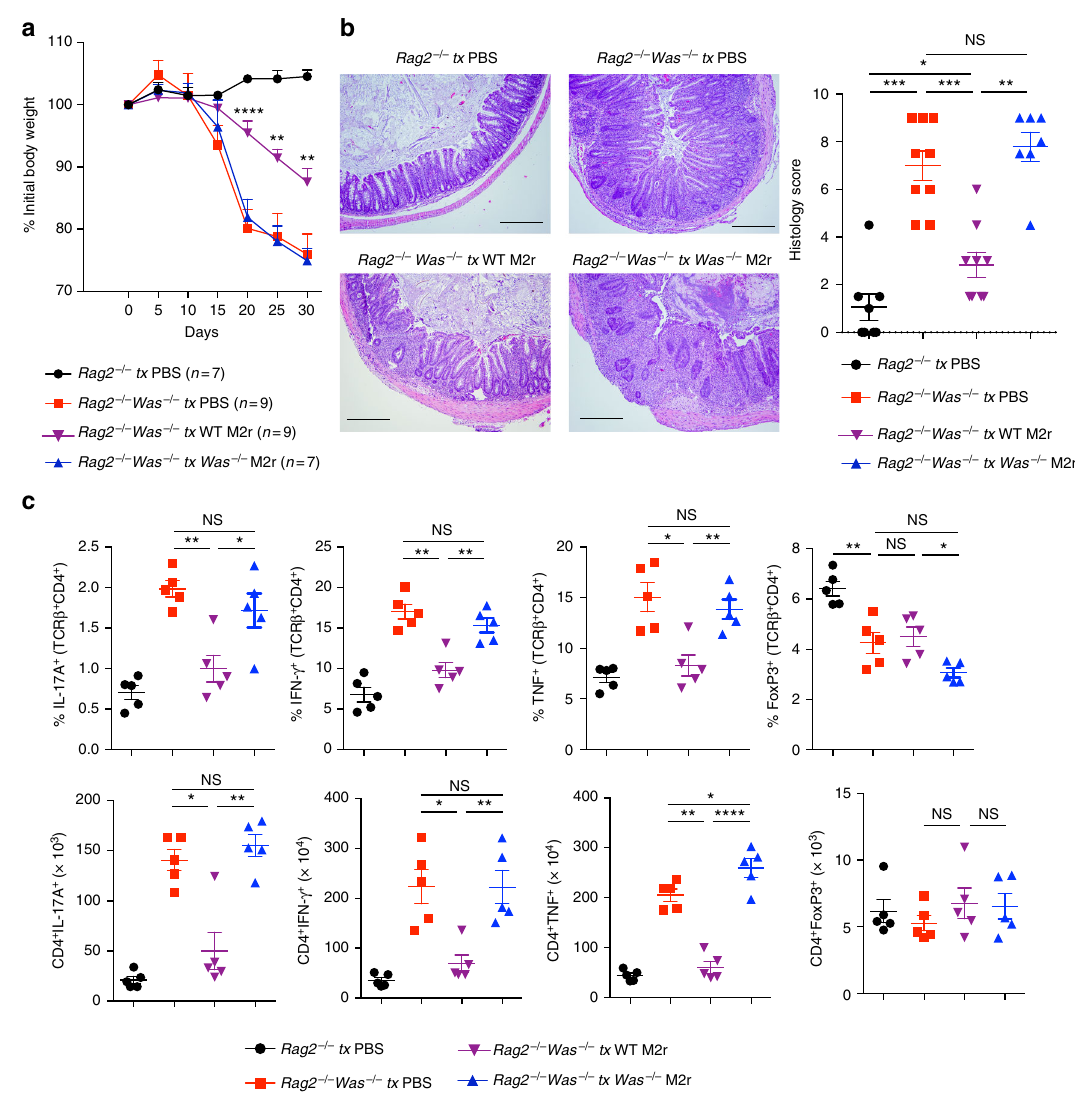
Fig. 5 Wild-type M2r macrophage protect Was − / − Rag − / − mice from T-cell-transfer-induced colitis. Was − / − Rag1 − / − mice were transfer with PBS ( n = 9), WT M2r (2 × 10 6 ) ( n = 9) or Was − / − M2r (2 × 10 6 ) ( n = 7) macrophages one-day before WT CD4 + T-cell transfer. As a control Rag1 − / − ( n = 7) were treated with PBS and transferred with WT CD4 + T cells. a Mean ± SEM % initial body weight after T-cell transfer. Data are cumulative of two independent experiments. * *p < 0.01, * **p < 0.001 (two-way ANOVA) ( Was − / − Rag1 − / − tx PBS Vs Was − / − Rag1 − / − tx WT M2r). b Representative photomicrographs of H&E stained colonic section and histological score. Scale bars: 200 μ m. c Absolute number and frequency of cytokine producing helper T cells in the LP was determined by fl ow cytometry. ( Rag1 − / − tx PBS n = 5; Was − / − Rag1 − / − tx PBS n = 5; Was − / − Rag1 − / − tx WT M2r n = 5; Was − / − Rag1 − / − tx Was − / − M2r n = 5). Data are cumulative of two independent experiments. Data shown in b , c are mean ± SEM and P -value was obtained by Student ’ s t -test. *p <